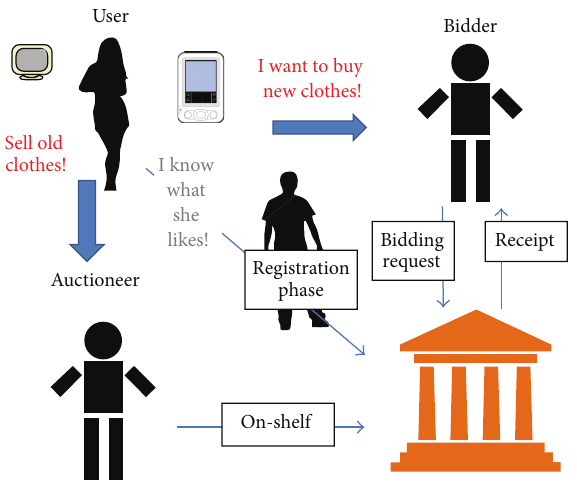
Figure 1: Privacy problem in electronic auction